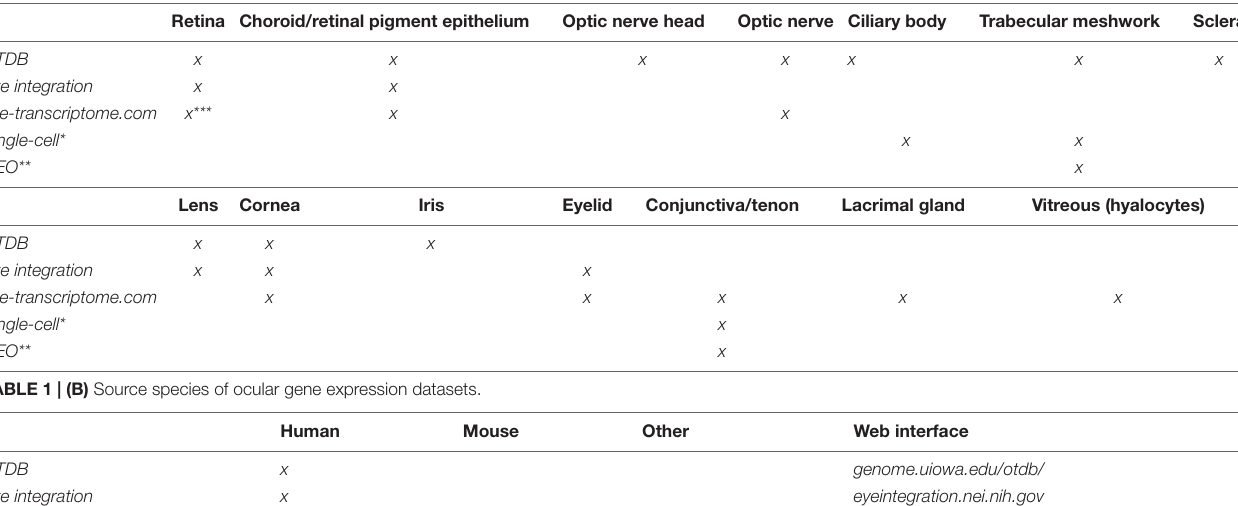
TABLE 1 | (A) Overlap of tissues described in ocular gene expression datasets. Retina Choroid/retinal pigment epithelium